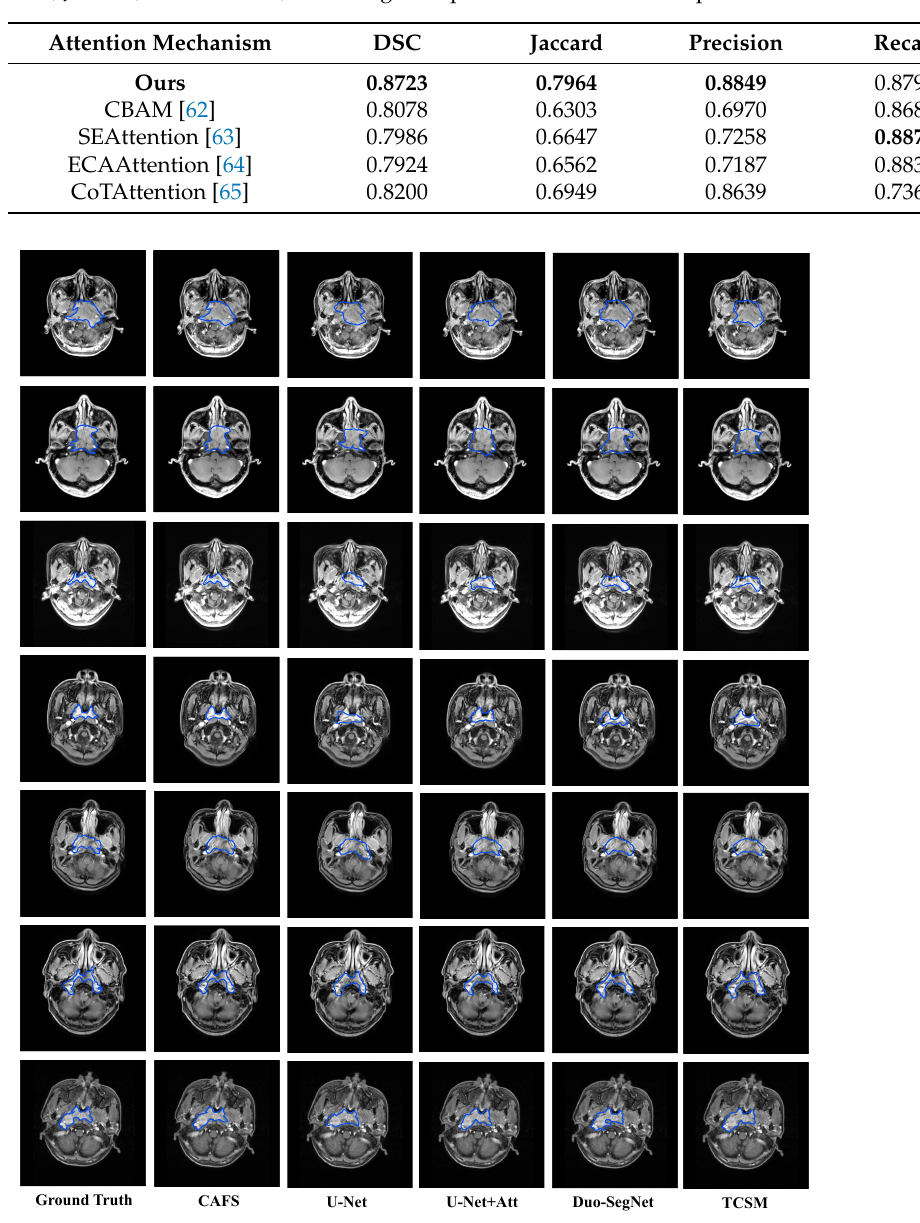
Figure 3. Segmentation results of five models. We selected several representative images of na- sopharyngeal carcinoma from the test set. These images are characterized by the similarity of the nasopharyngeal carcinoma to the surrounding tissue (rows 1, 3, 7) and the complexity of the nasopha- ryngeal carcinoma boundaries (rows 2, 4, 5, 6). From left to right, they are ground truth, CAFS, U-Net, U-Net + Attention, Duo-SegNet, and TCSM. The blue line in the figure represents the boundaries of each model nasopharyngeal carcinoma segmentation